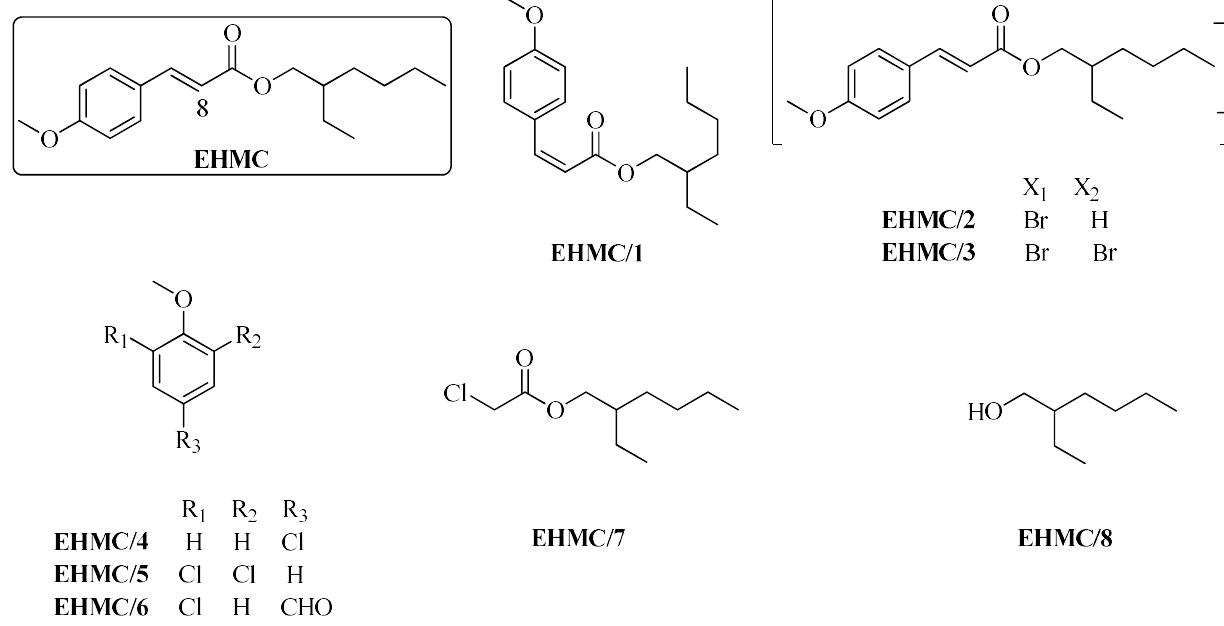
Figure 9. Disinfection by-products from EHMC